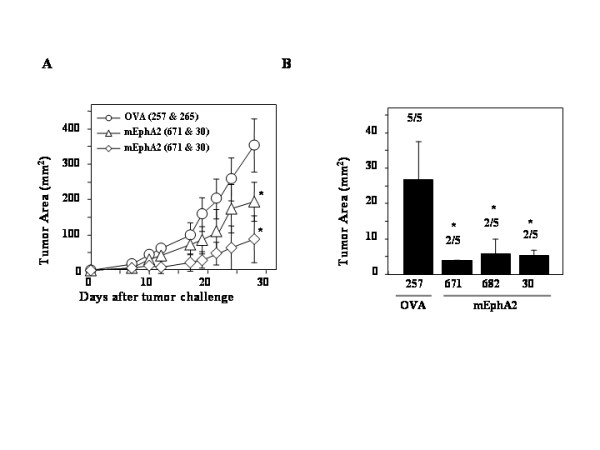
Immunizations with DCs loaded with Eph-A2 derived peptides inhibit the growth of both EphA2-positive and EphA2-negative tumors. (A) C57BL/6 mice received 1 × 105 MCA205 cells s.c. on day 0. These animals were then immunized with 1 × 106 DCs loaded with the indicated peptides on days 3, 10. Tumor growth was monitored for 28 days following the tumor inoculation (N = 5/group). P < 0.05 for both mEphA2671–679/30–44 and mEphA2682–689/30–44 treatments in comparison to OVA control for the tumor based on a two-tailed Student-t test (*). (B) C57BL/6 mice received s.c. pre-immunizations with 1 × 106 DCs loaded with either mEphA2671–679, mEphA2682–689, mEphA230–44 or control OVA257–264 on days -14 and -7 (N = 5 /group), followed by s.c. challenge with 5 × 104 B16 melanoma cells on day 0. On day 14, the size of tumors and the number of animals that had measurable tumors were assessed. P < 0.01 for EphA2671–679, EphA2682–689 and EphA230–44 treatments in comparison to OVA257–264 treated group (*).